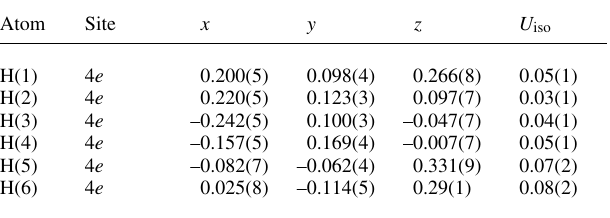
Table 10. Data collection and handling. Table 11. Atomic coordinates and displacement parameters (in Å 2 ) .